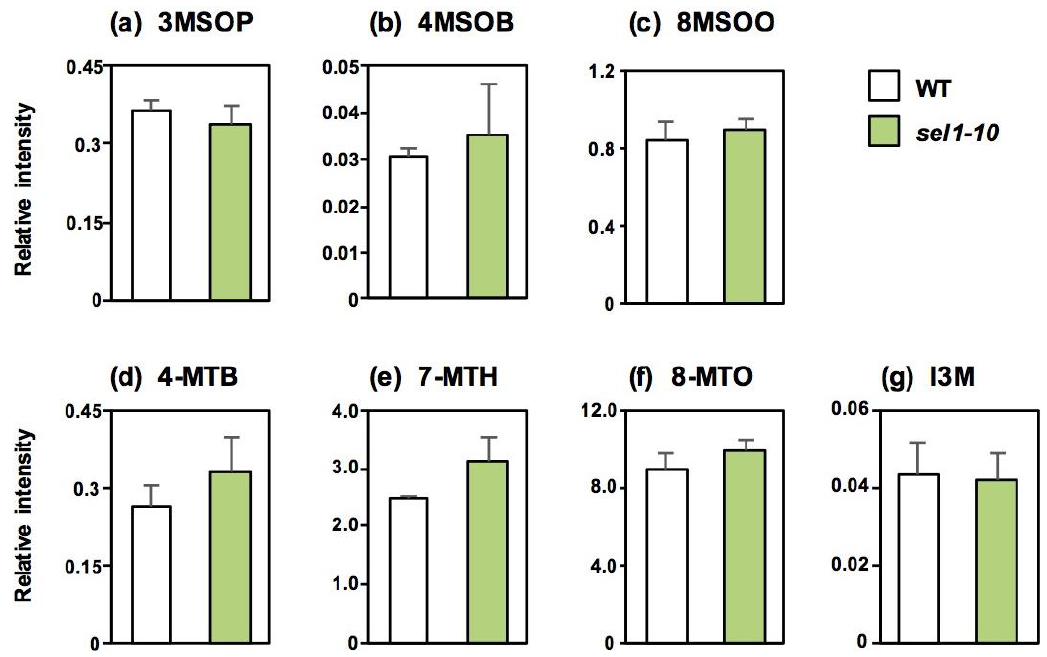
Figure 5. GSL accumulation in mature seeds of WT and sel1-10 plants. GSL levels in seeds were determined by LC-MS. The relative amount was calculated as the ratio of peak height of each GSL to that of the internal standard (L(+)-10-camphor sulfonic acid) and then divided by the dry weight of the sample. ( a ) 3-methylsulfinylpropyl GSL (3MSOP), ( b ) 4-methylsulfinylbutyl GSL (4MSOB), ( c ) 8-methylsulfinyloctyl GSL (8MSOO), ( d ) 4-methylthiobutyl GSL (4MTB), ( e ) 7-methylthioheptyl GSL (7MTH), ( f ) 8-methylthiooctyl GSL (8MTO), ( g ) indol-3-ylmethyl GSL (I3M). White and green bars represent the relative GSL content in WT and sel1-10 seeds, respectively. Data are shown as averages with error bars denoting SEM (n = 3). Statistical analysis was performed with Student’s t -test between WT and sel1-10 plants, but any significant differences were not detected.